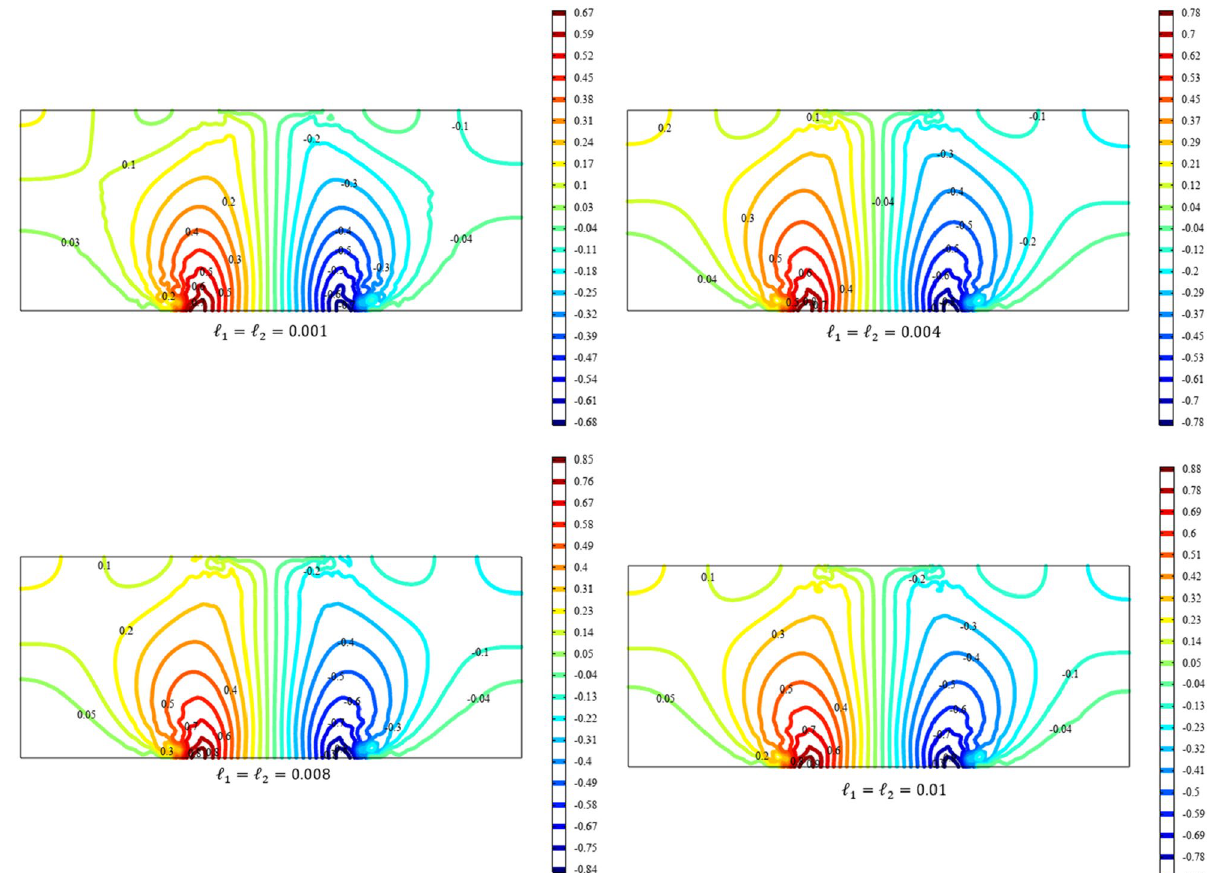
/ | u 0 | for different values of ℓ 1 and ℓ 2 (COMSOL (cid:30)